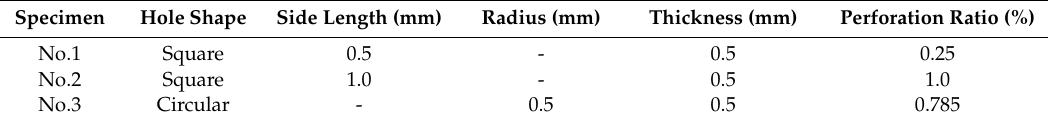
Table 1. Targeted parameters for trial production using a 3D printer.